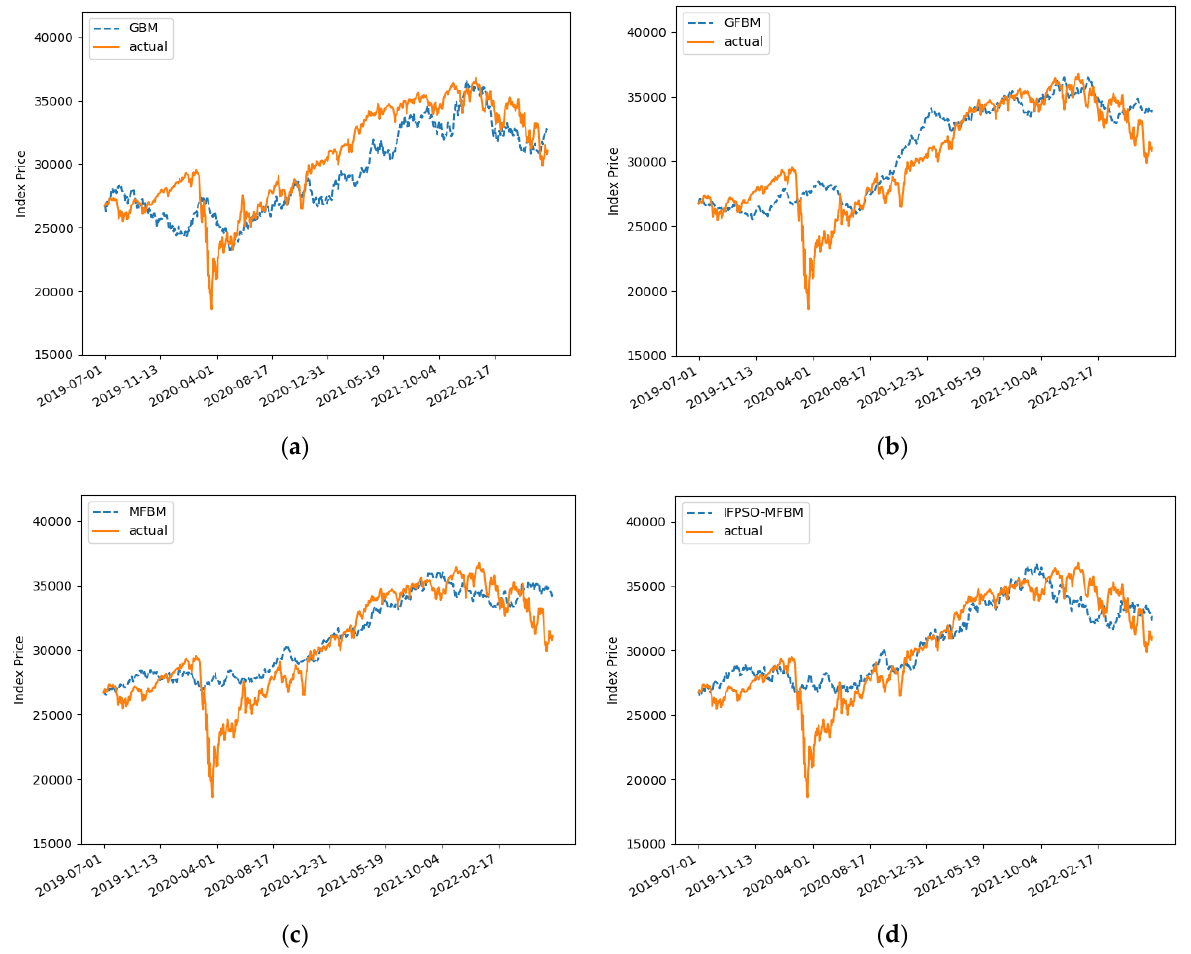
Figure 8. True vs. predicted values of the Dow Jones index under the four models. ( a ) GBM, ( b ) GFBM, ( c ) MFBM, ( d ) IFPSO-MFBM.